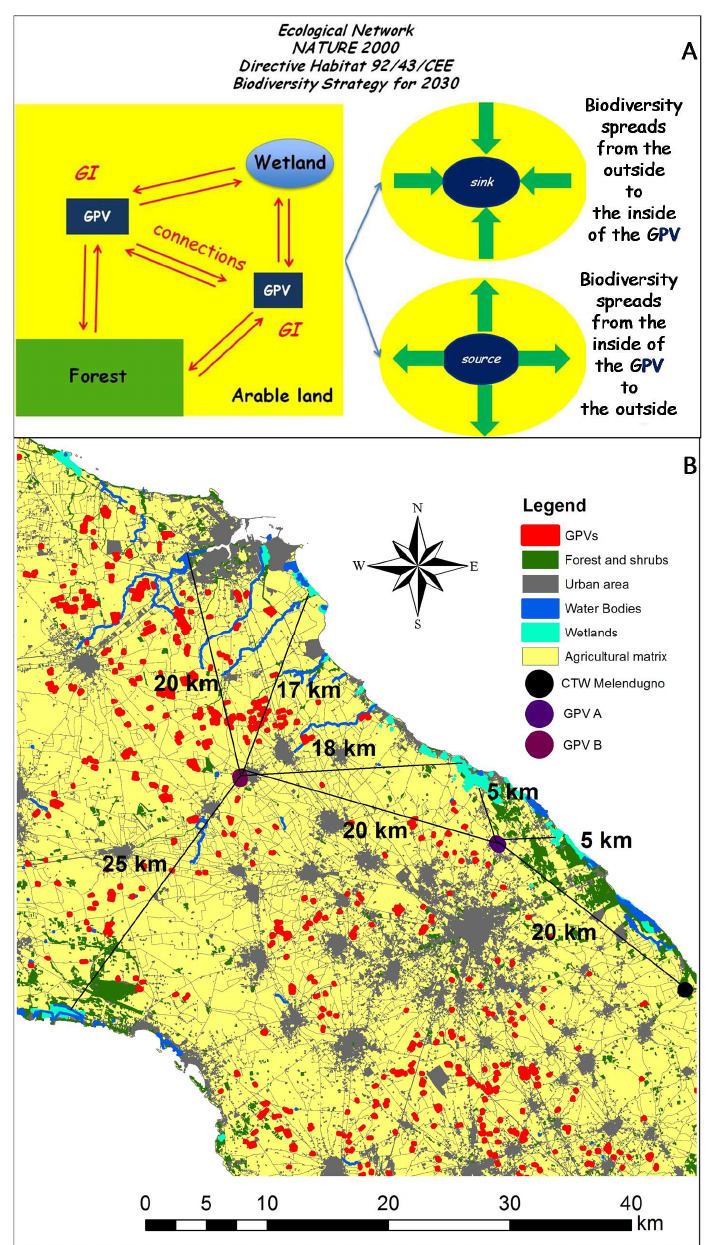
Figure 10. GPV systems thought as GI, representing an ecological functional element of the landscape: ( a ) Conceptual scheme of the ecological network considering GPV systems like GI; ( b ) potential ecological network that can be realised in the landscape of reference, considering the conversion of GPV systems A and B (Table 2 and Figure 4) into CTWs.